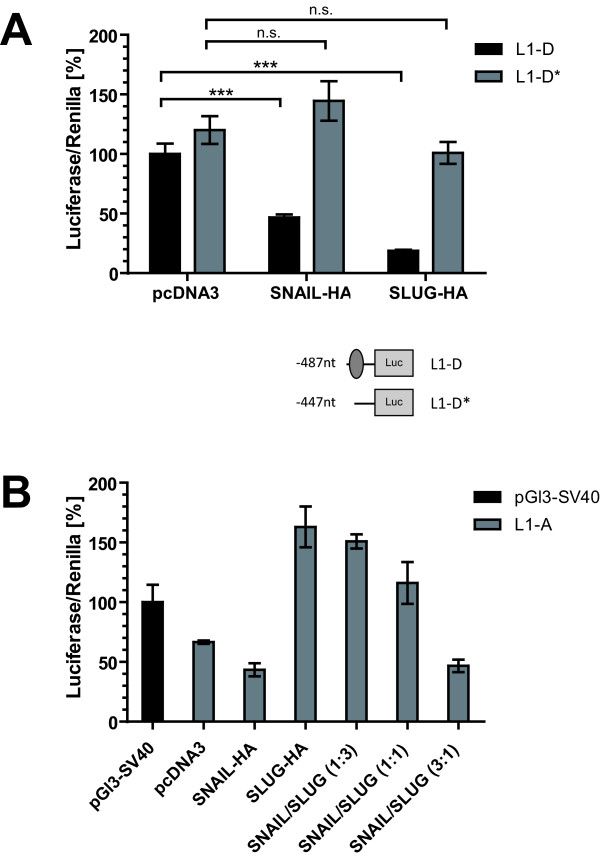
Transcription factor overexpression and L1CAM promoter luciferase activity. (A) Demonstration that E-boxes are essential for promoter 2 activity. In the minimally active promoter construct pGl3-L1-D the E-box (E1) was deleted and analysed in Ishikawa cells for promoter activity. (B) The ratio of Slug/Snail determines the outcome of promoter 2 activity. The pGl3-L1-A promoter constructs was co-transfected with different ratios of Slug in Ishikawa cells and promoter activity was determined after 48 h. Data ± SD of representative experiments from each n = 3 is shown. (*** p ≤ 0.001, **p ≤ 0.01, *p ≤ 0.05, n.s. not signicicant).